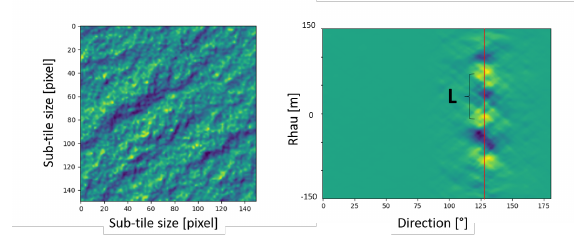
Figure 3. Raw offshore sub-tile from 03/2020 Pleiades imagery (2 m resolution pixel) (left) and its associated sinogram calculated with Radon Transform (right) . The signal picked to estimate the waves parameters along the forced direction is in red, and the wavelength L corresponds to the distance between two intensity peaks.